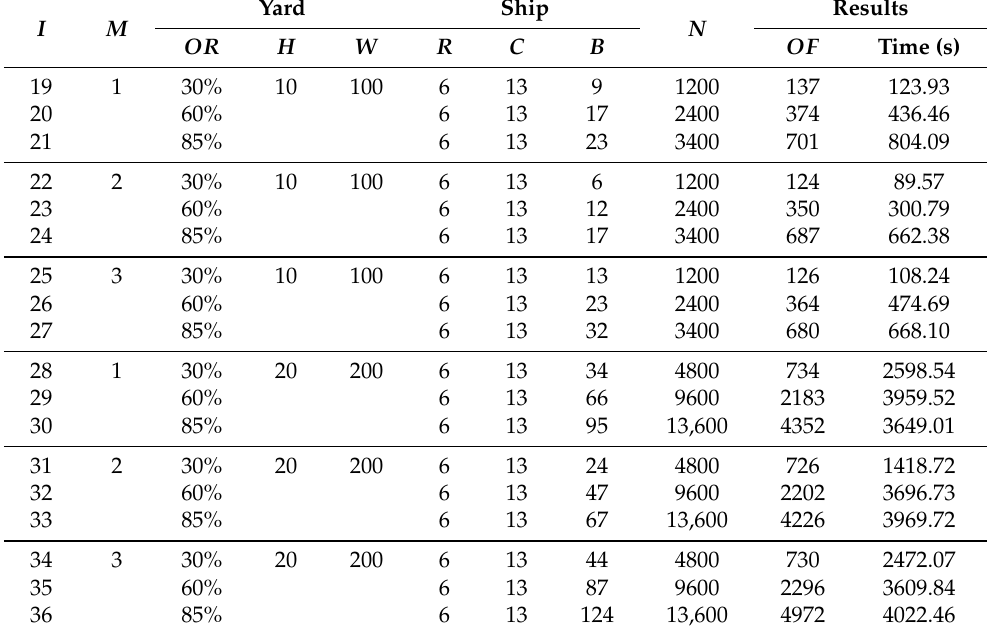
Table 2. Computational results for large-sized instances for a problem with five